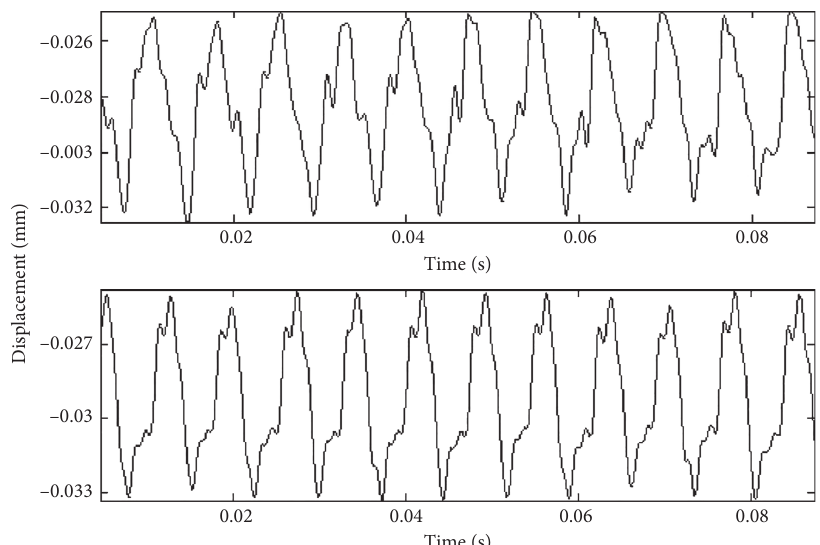
Figure 22: Radial position of the rotor when the rotor was running at 8000rpm. (a) x -axis position of the rotor. (b) y -axis position of the